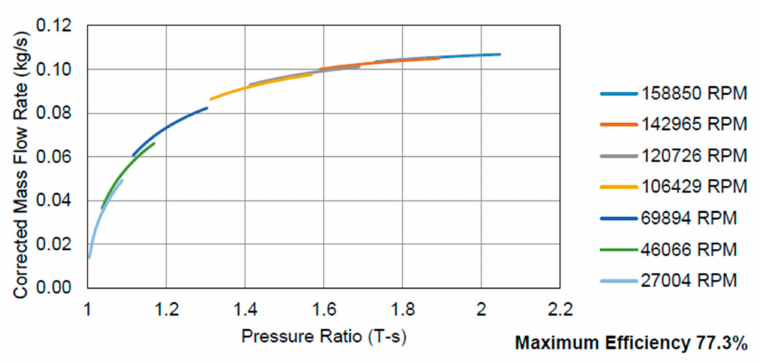
Figure 25. Mass flow rate vs. pressure ratio plots at constant shaft speeds for axial